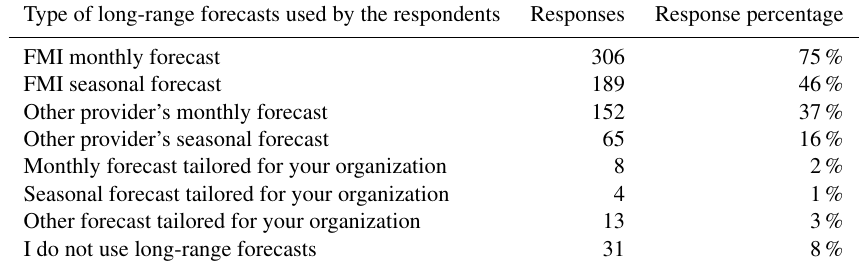
Table 2. The provider and the type of long-range forecast that the respondents ( N = 408) were familiar with. Type of long-range forecasts used by the respondents Responses